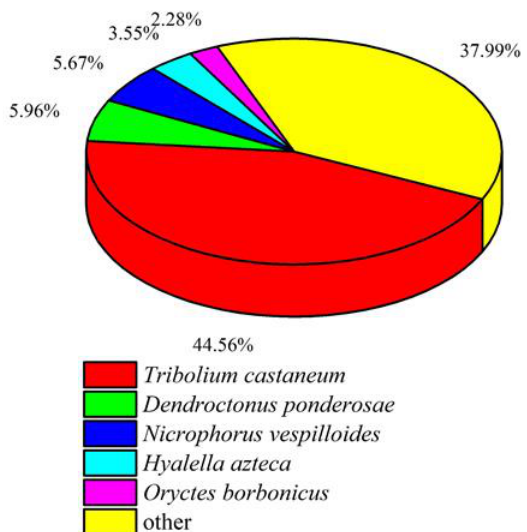
Figure 1. All unigene sequences for P. quatuordecimpunctata that had blast annotations to the NR database were analyzed for species distribution.